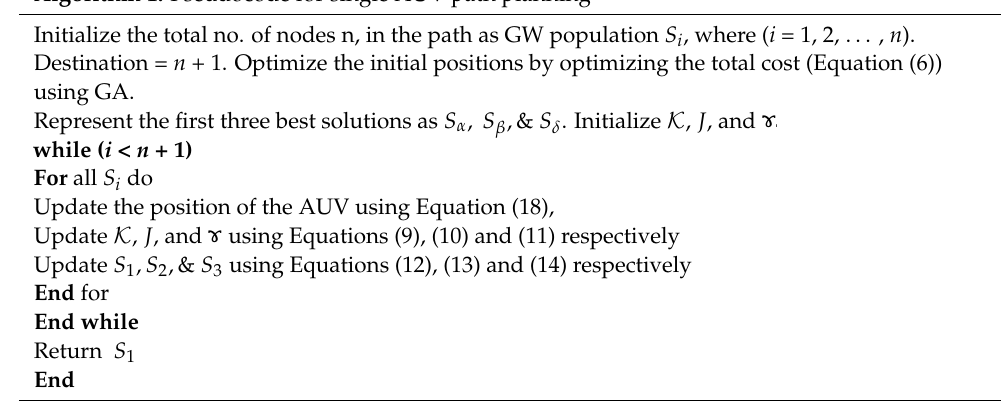
Algorithm 1. Pseudocode for single AUV path planning